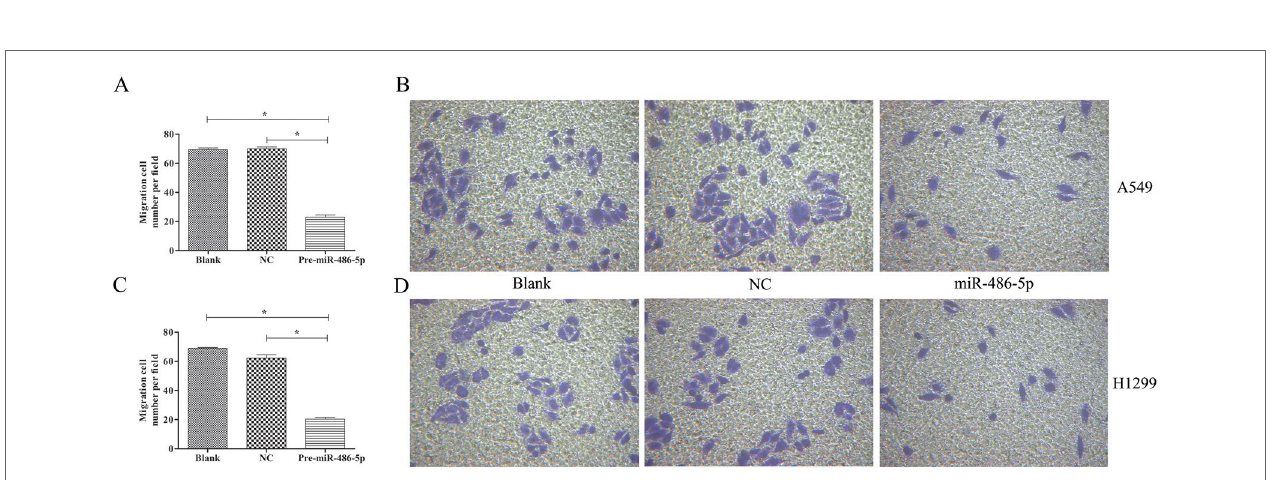
FIGURE 6 | Overexpressed miR-486-5p significantly inhibited A549 and H1299 cell invasion. (A) The migrated cell numbers of A549 cells were significantly reduced after 72 h incubation by Transwell assay. The number of cells was calculated with crystal violet staining. (B) Representative pictures of Transwell assay in A549 cell lines. Similar results were obtained in three independent experiments. (C) The migrated cell numbers of H1299 cells after 48 h incubation. (D) Representative pictures of Transwell assay in H1299 cell lines. * p <